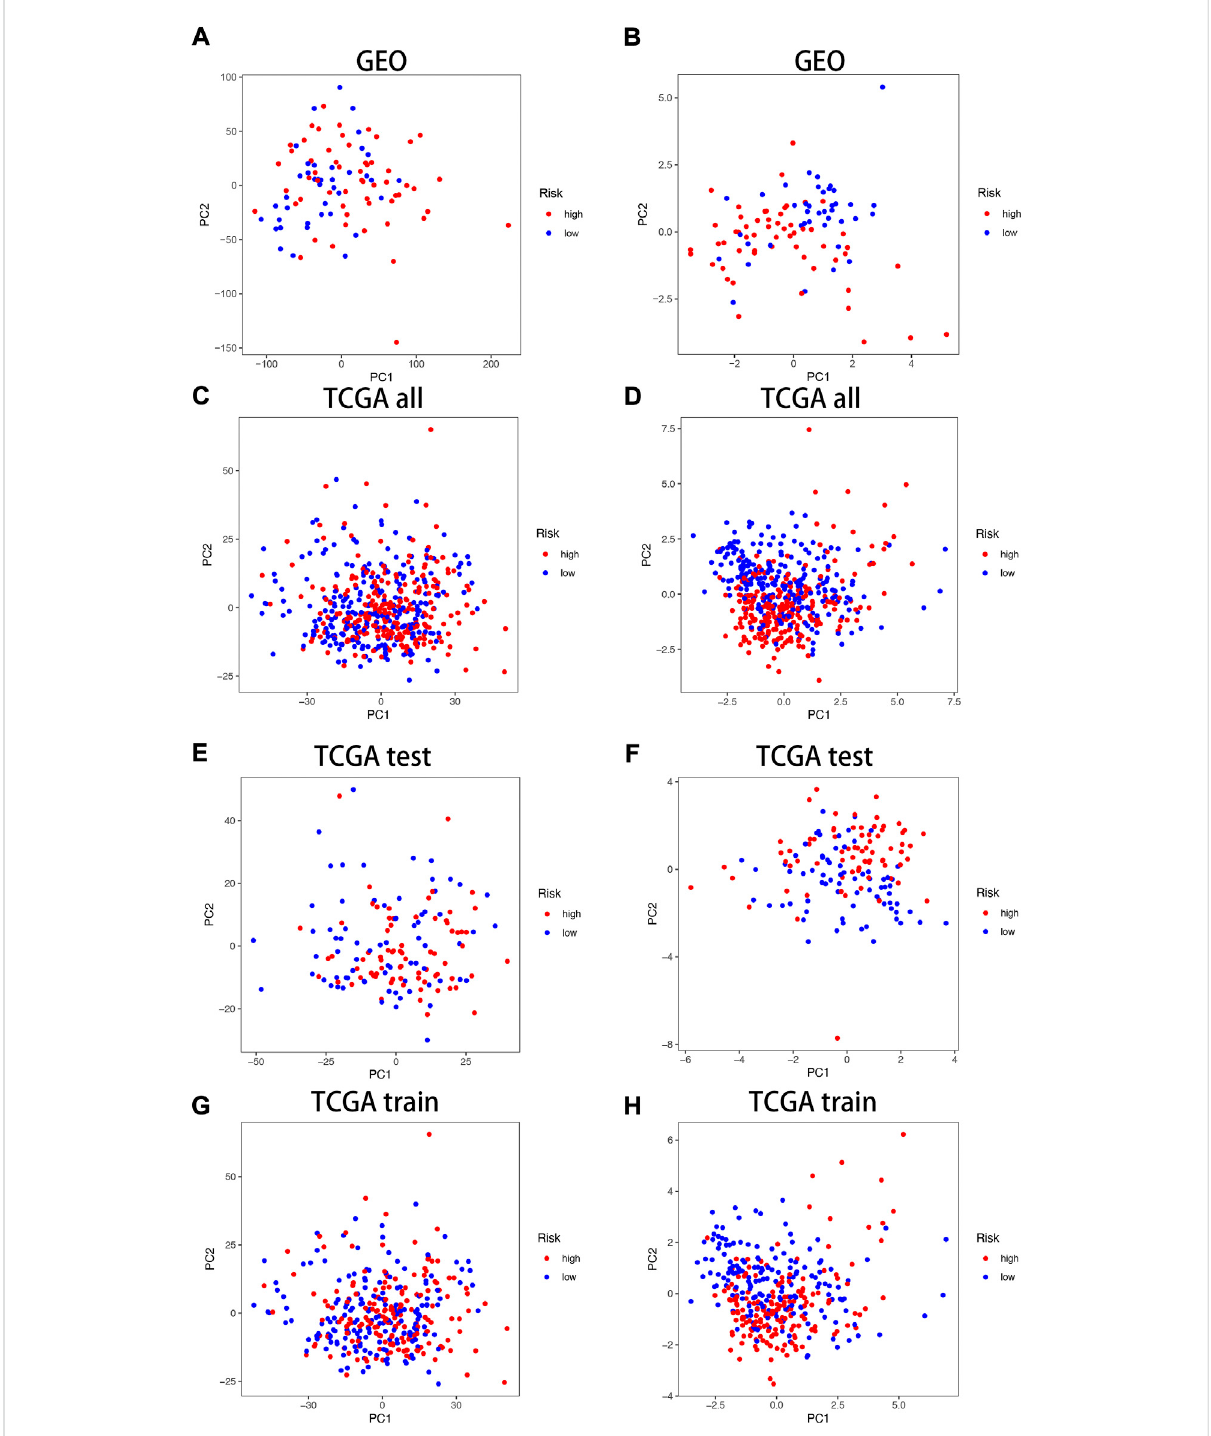
FIGURE 4 PCAcorrelationanalysisinTCGAandGEOCohorts.InGEOCohort: (A) PCAplotsofneurotrophicfactorgenes; (B) PCAplotsofmodelgenes.In TCGA Cohort: (C) PCA plots of neurotrophic factor genes in the sum group; (D) PCA plots of model genes in the sum group; (E) PCA plots of neurotrophicfactorgenesinthetestgroup; (F) PCAplotsofmodelgenesinthetestgroup; (G) PCAplotsofneurotrophicfactorgenesinthetraining group; (H) PCA plots of model genes in the training